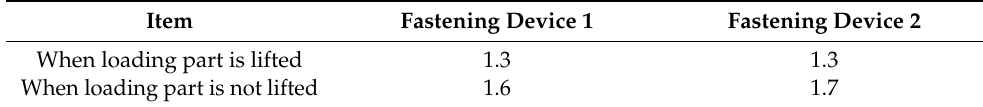
Figure 12. Measured stress at each fastening device when loading part not lifted: ( a ) fastening device 1; ( b ) fastening device 2. Table 4. Static safety factor of the fastening